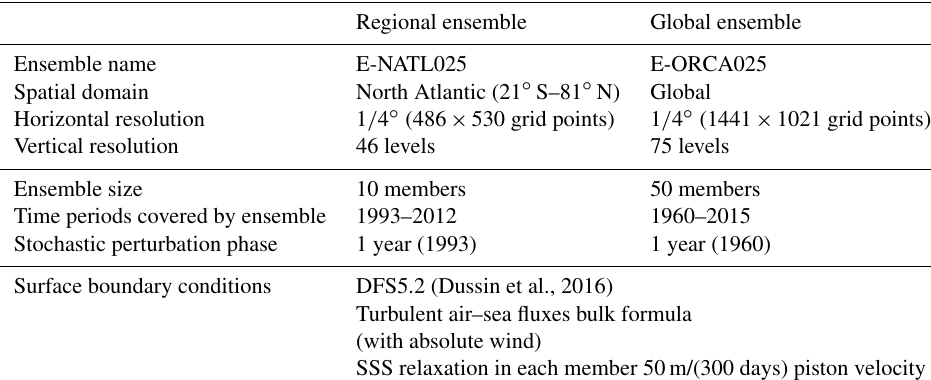
Table 1. Main characteristics of the NEMO 3.5 set-up used for the regional and global OCCIPUT